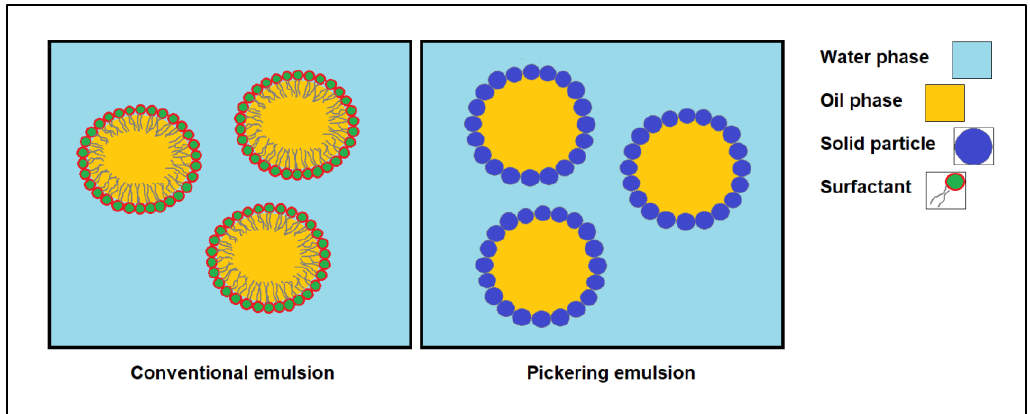
Figure 5. Schematic diagram of the structure of conventional emulsion and Pickering